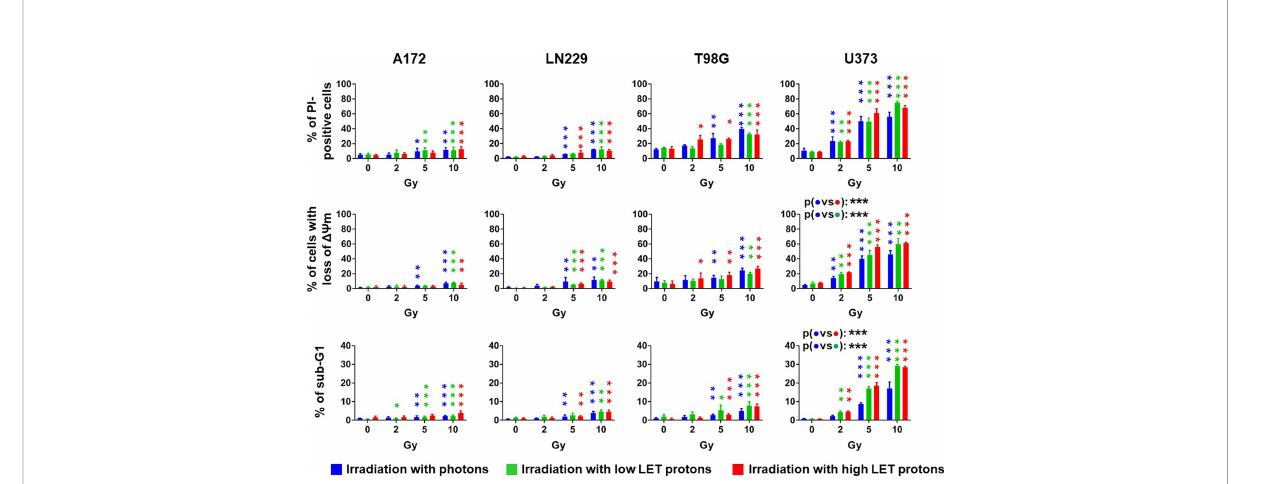
FIGURE 2 The irradiation technique does not affect radiation-induced cell death. Glioblastoma cells were irradiated with photons (blue), low LET protons (green) or high LET protons (red) at 0 Gy, 2 Gy, 5 Gy, and 10 Gy. 72 h later, cells death was determined by fl ow cytometry using propidium- iodide (PI) exclusion assay (upper panels) or by measuring dissipation of mitochondrial membrane potential ( DY m, middle panels). Apoptosis was determined by analyzing DNA fragmentation (cells with sub G1 fraction) after permeabilizing and staining cells with PI (lower panels). N ≥ 3. *, ** and *** above the bars indicate signi fi cance to respective sham-irradiated controls. *p < 0.05; **p < 0.01; ***p <